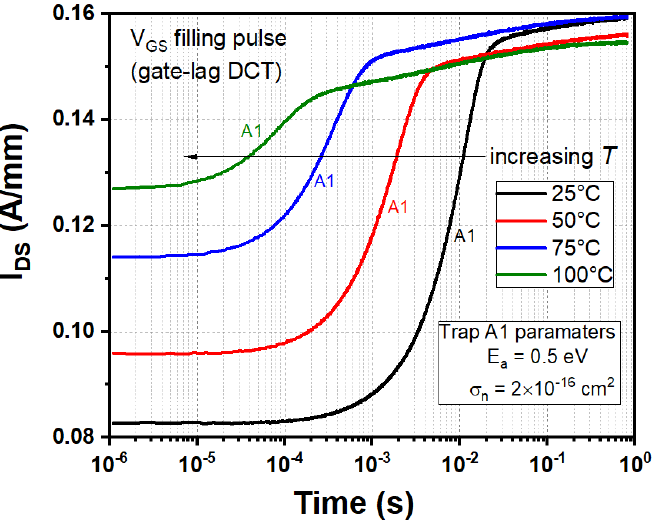
Figure 6. DCT spectra obtained with the gate-lag filling pulse ( V G pulsed from − 2 to − 5 V during the trap-filling phase) also reveal the trap A1 at 0.5 eV.